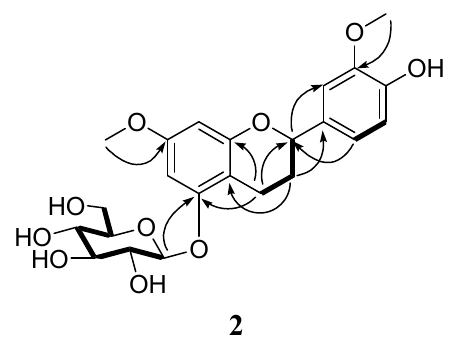
Figure 3. Key COSY ( ) and HMBC ( → ) correlations of